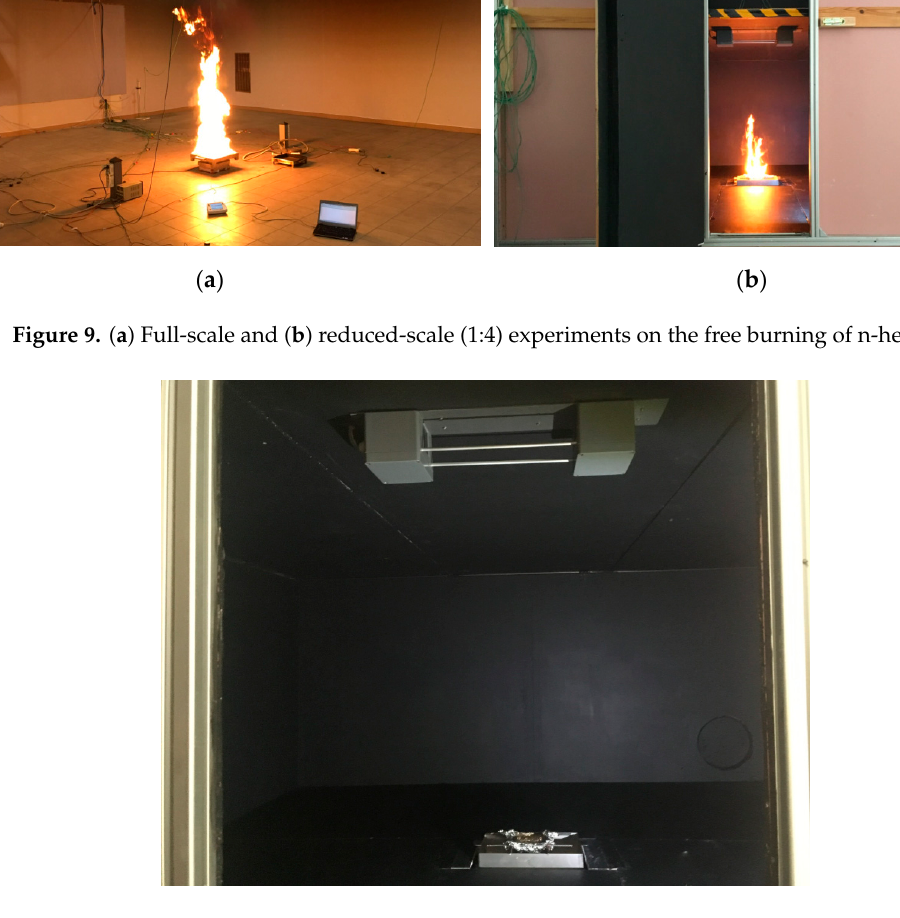
Figure 10. The interior of a reduced-scale (1:4) chamber with visible reduced-scale optical densitometer mounted underneath the ceiling.